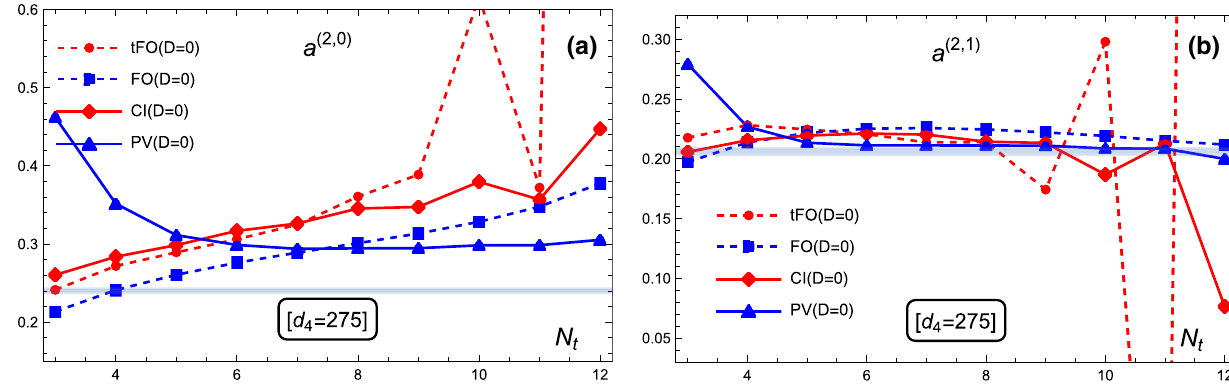
Fig. 5 The moment a ( 2 , 0 ) (σ m ) D = 0 ( a ) and a ( 2 , 1 ) (σ m ) D = 0 ( b ), as a function of the truncation index N t , in the four considered approaches. For all N t , the corresponding value of the parameter α s was kept fixed for each method (cf. the text for